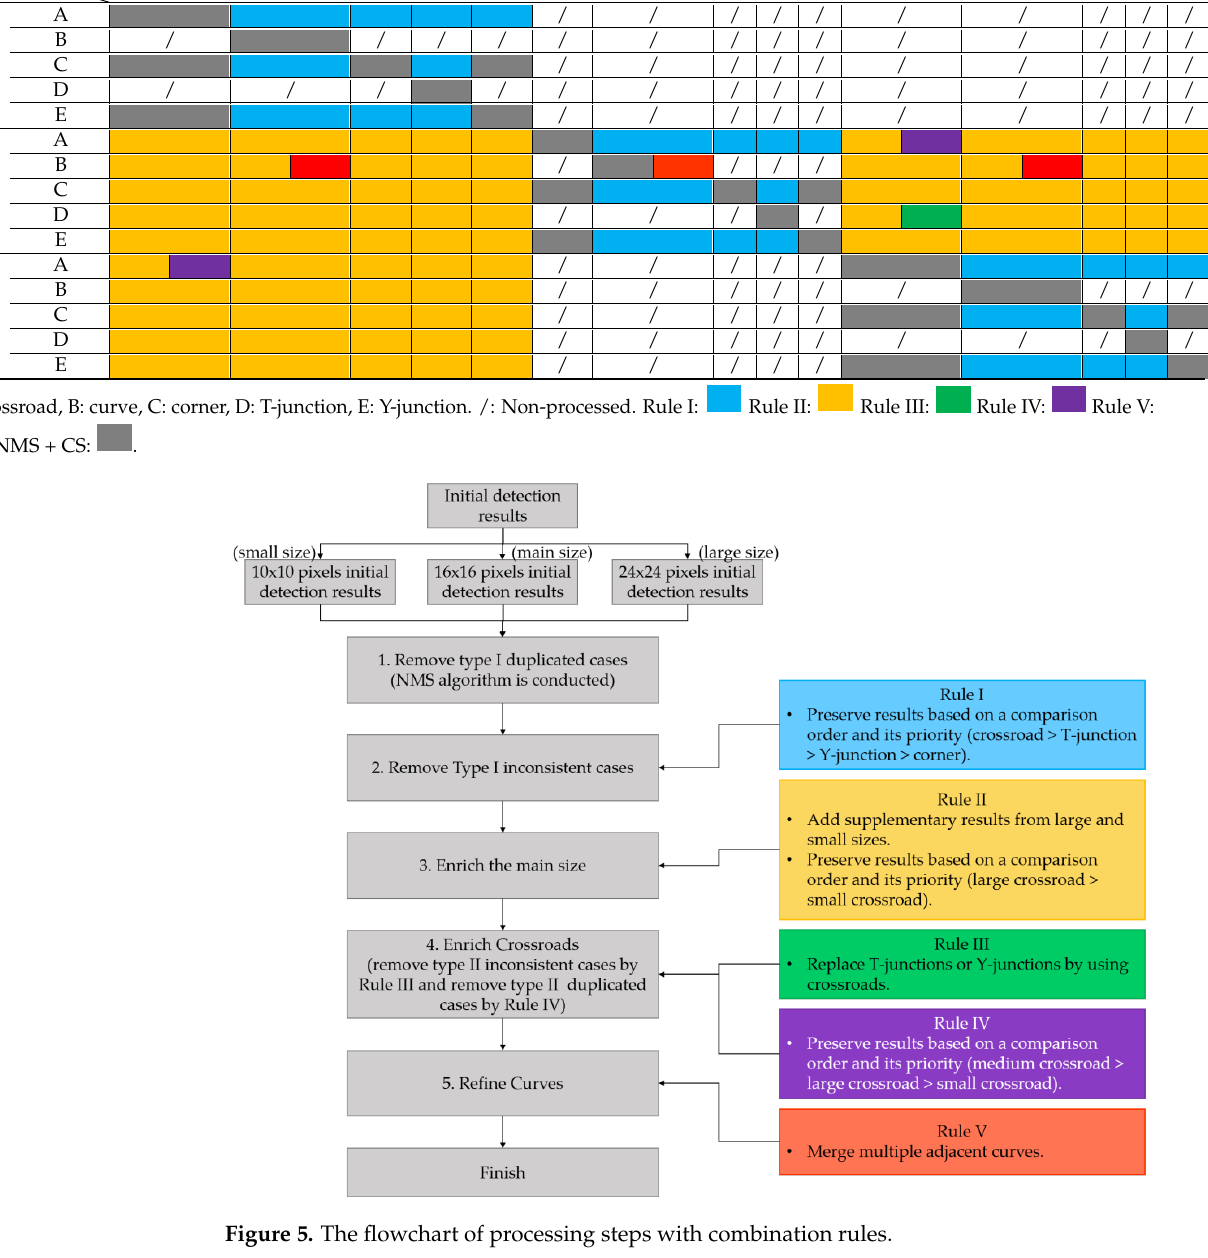
Figure 5. The flowchart of processing steps with combination rules.